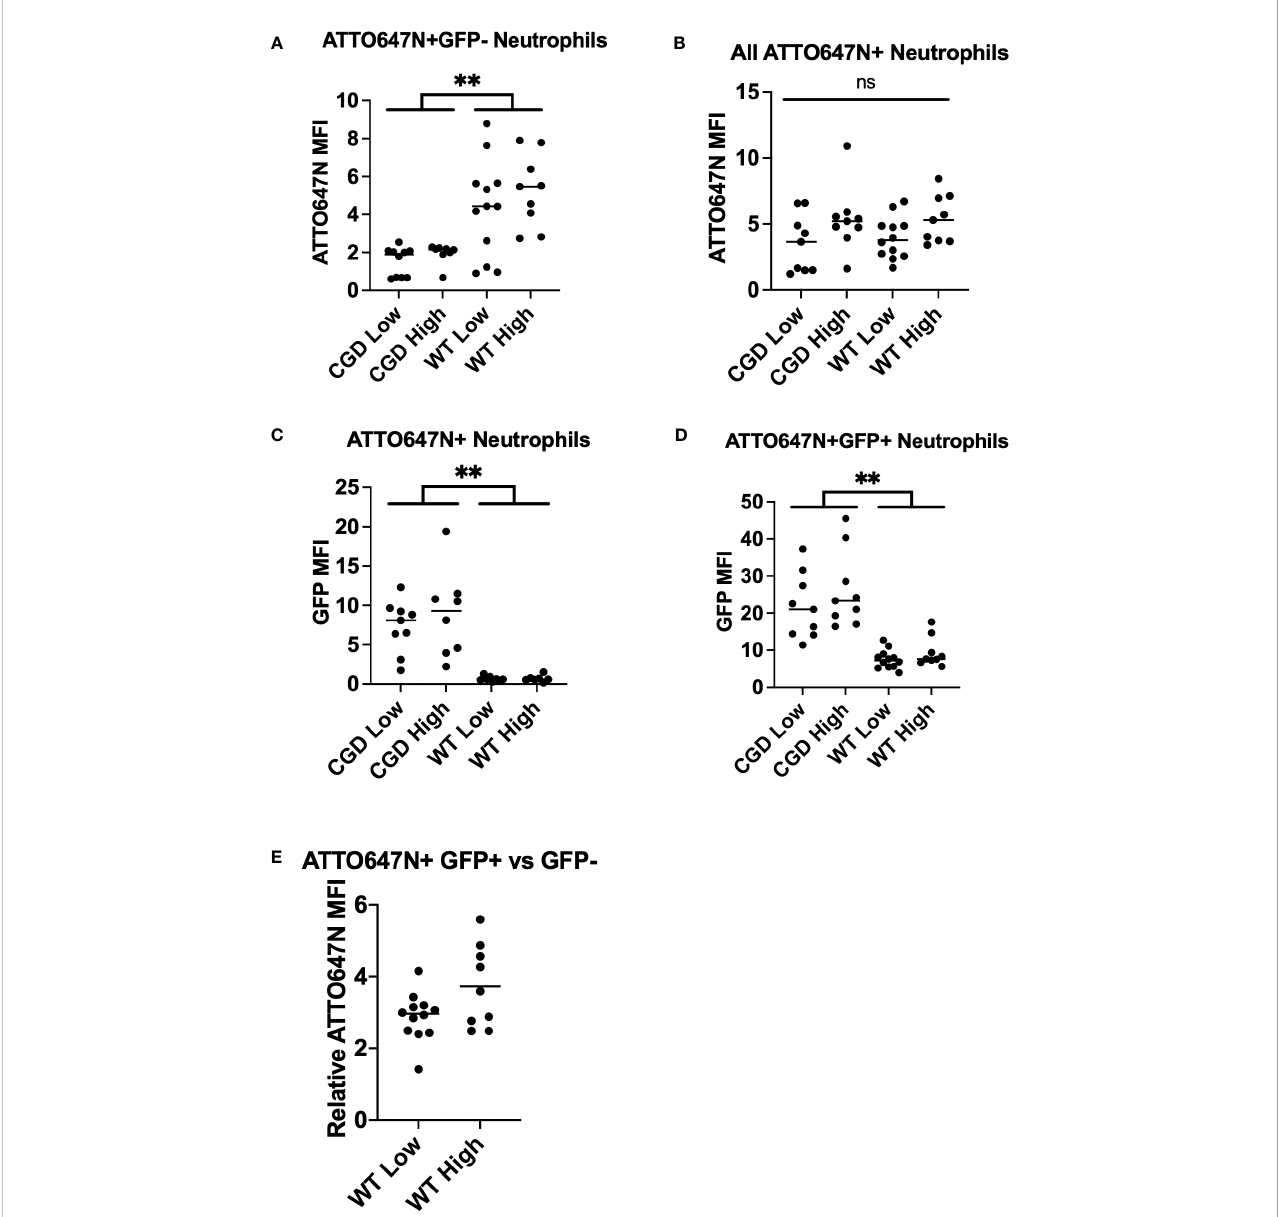
FIGURE 5 Analysis of BAL neutrophil subpopulation fl uorescent intensities. (A) WT neutrophils have increased ATTO647N MFI for neutrophils that have completed killing, indicating clearance of larger bacterial burdens on a per-cell basis. (B) The neutrophil ATTO647N MFI was comparable between groups implying similar levels of phagocytosis. (C) The GFP MFI for all ATTO647N + events demonstrate an increased bacterial burden in phagocytosing CGD neutrophils relative to WT neutrophils. (D) GFP MFI of the ATTO647M + GFP + population demonstrates the same trend of increased intensity in CGD animals. (E) The relative ATTO647N MFI was calculated by dividing the ATTO647N MFI of ATTO647N + GFP + events by ATTO647N + GFP - events (n=8-11 animals per group, from 7 independent experiments). “ ns ” (not signi fi cant) for p>0.05, ** for